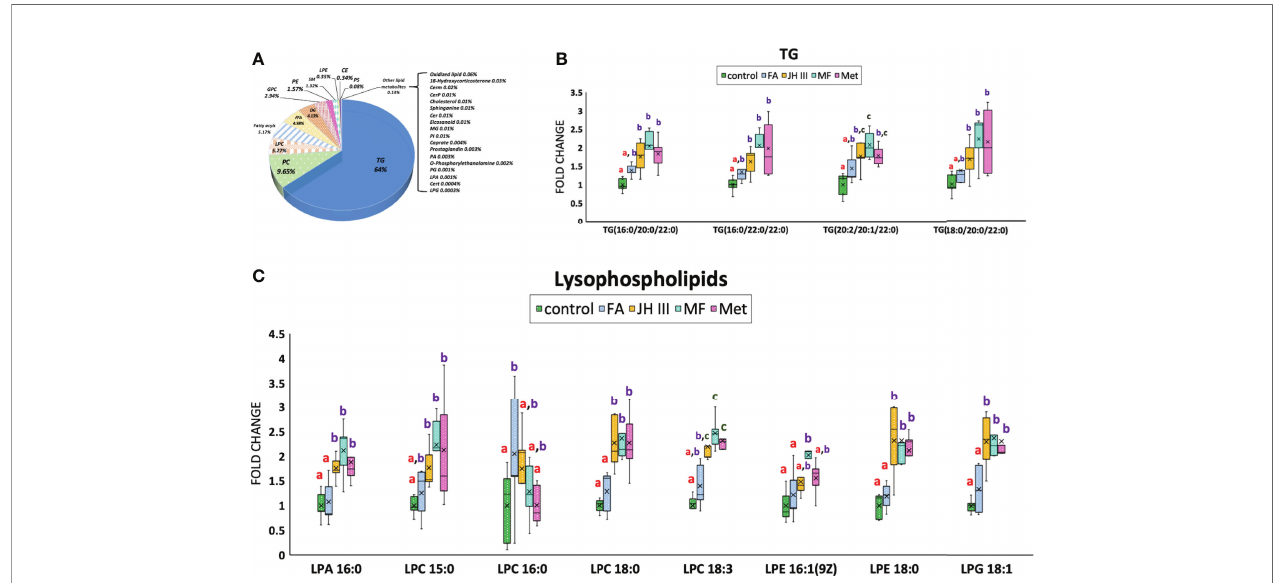
FIGURE 4 | Changes of lipid accumulation and composition in hepatopancreas of S. paramamosain under different hormonal treatments. (A) Lipid subclasses identi fi ed in hepatopancreas ofthe mud crab andtheircorresponding percentages. Impact of treatments on the content of major lipid classes (B) TG and (C) lysophospholipids were presentedin fold change. Different letters above boxes and whiskers denote signi fi cantdifference between treatments at P ≤ 0.05 (n = 5).TG, triglyceride; PC, phosphatidyl choline; LPC, lyso-phosphatidylcholine; FFA, free fatty acid; DG, diacylglyceride; GPC, glycerylphosphorylcholine; PE, phosphatidyl ethanolamine; SM,sphingomyelin;LPE, lyso-phosphatidyl ethanolamine; CE, cholesterol ester; PS, phosphatidylserine; LPA, lyso-phosphatidicacid; LPG, lyso-phosphatidyl glycerol.